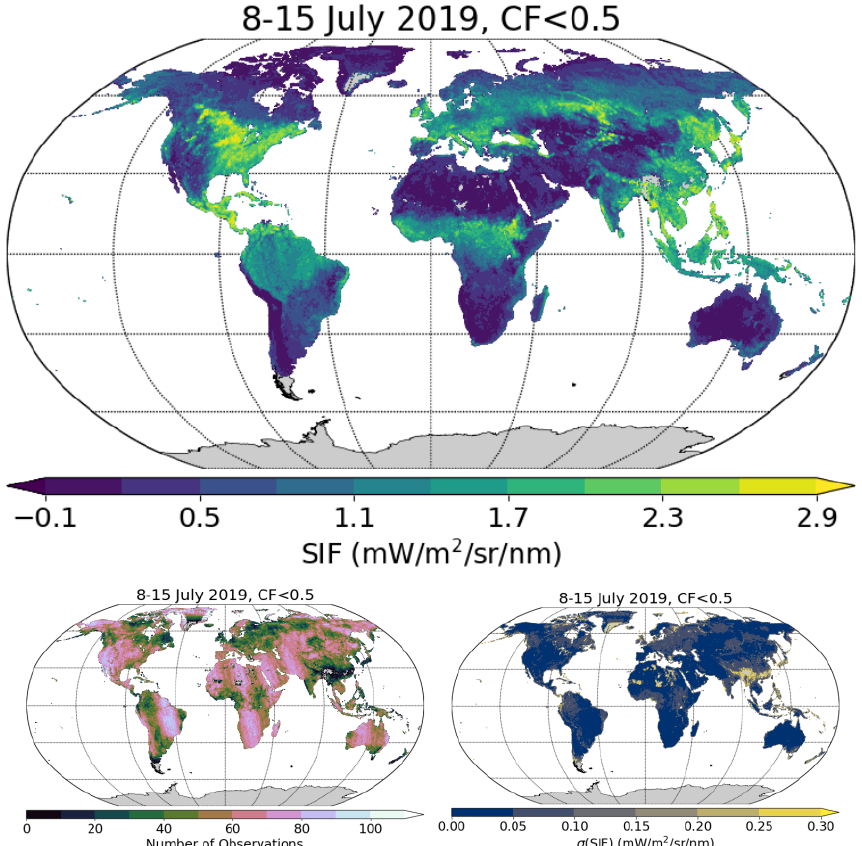
Figure 6. Global composites of SIF at 740nm for the time period 8–15 July 2019 using retrievals from the 743–758nm fitting window and a cloud fraction (CF) threshold of 0.5. Data are gridded in 0.2 ◦ grid boxes. The number of observations and the resulting standard error of the mean per grid box are shown in the lower panels.